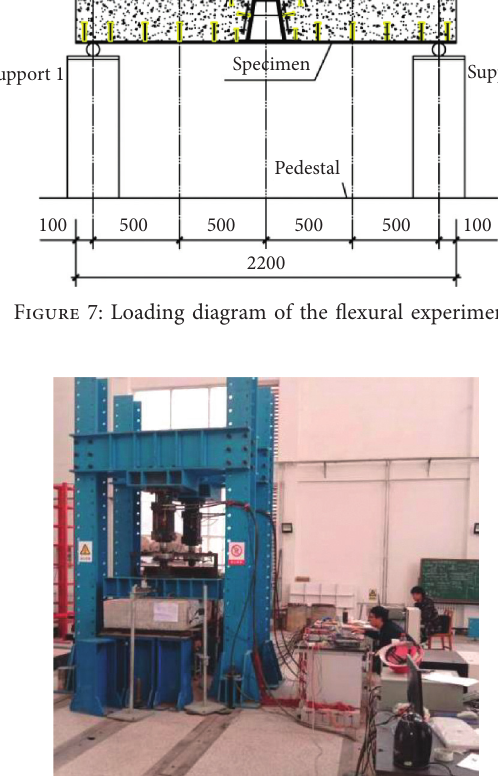
Figure 8: Field loading and testing of the flexural experiment.